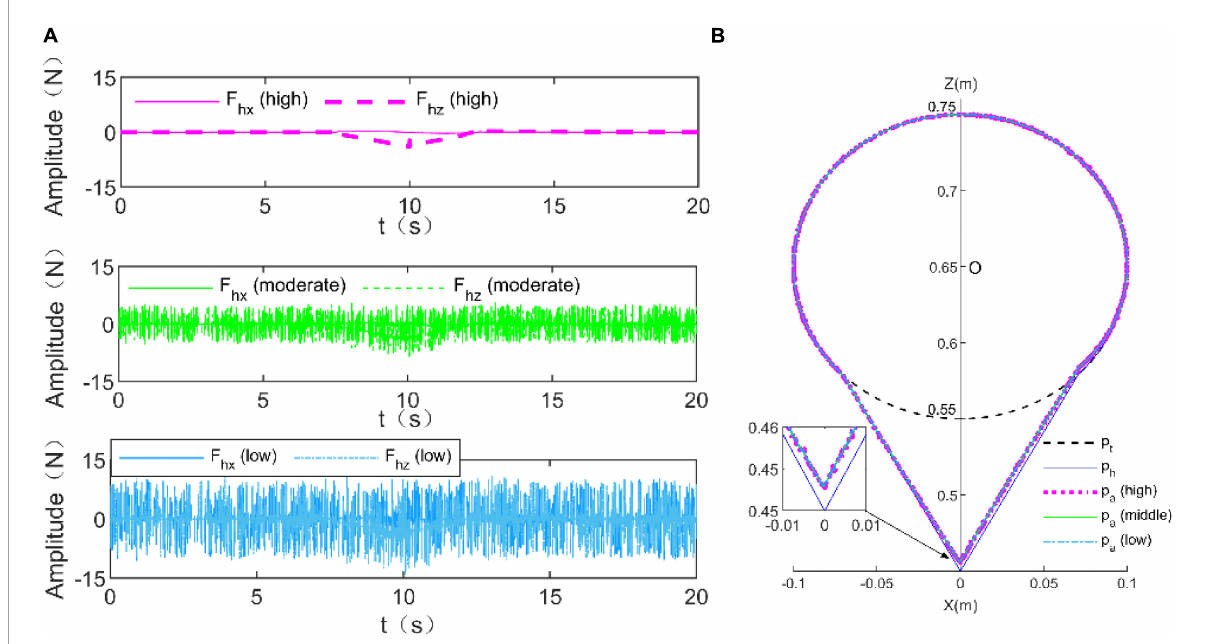
FIGURE5 Simulation results for trajectory tracking performance under the voluntary force generated by the human dynamics models with three different levels of capabilities. (A) Human voluntary forces for high (violet), moderate (green), and low (blue) levels of capabilities. (B) Trajectory tracking